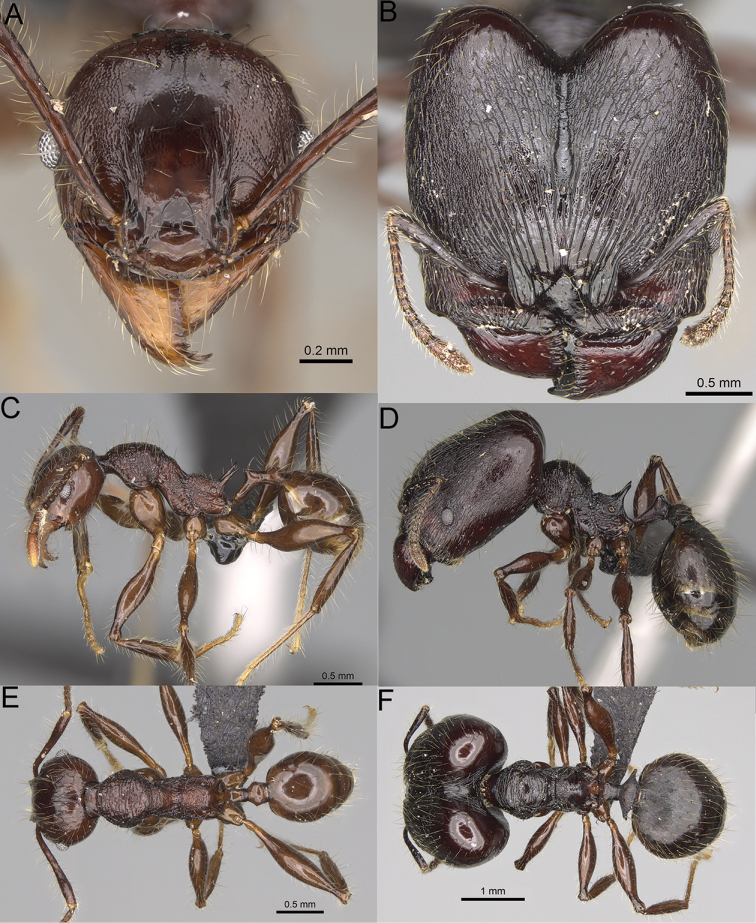
Pheidole
scabrata Forel, full-face view (A), profile (C), and dorsal view (E) of minor worker (CASENT0496745) and full-face view (B), profile (D), and dorsal view (F) of major worker (CASENT0496747).